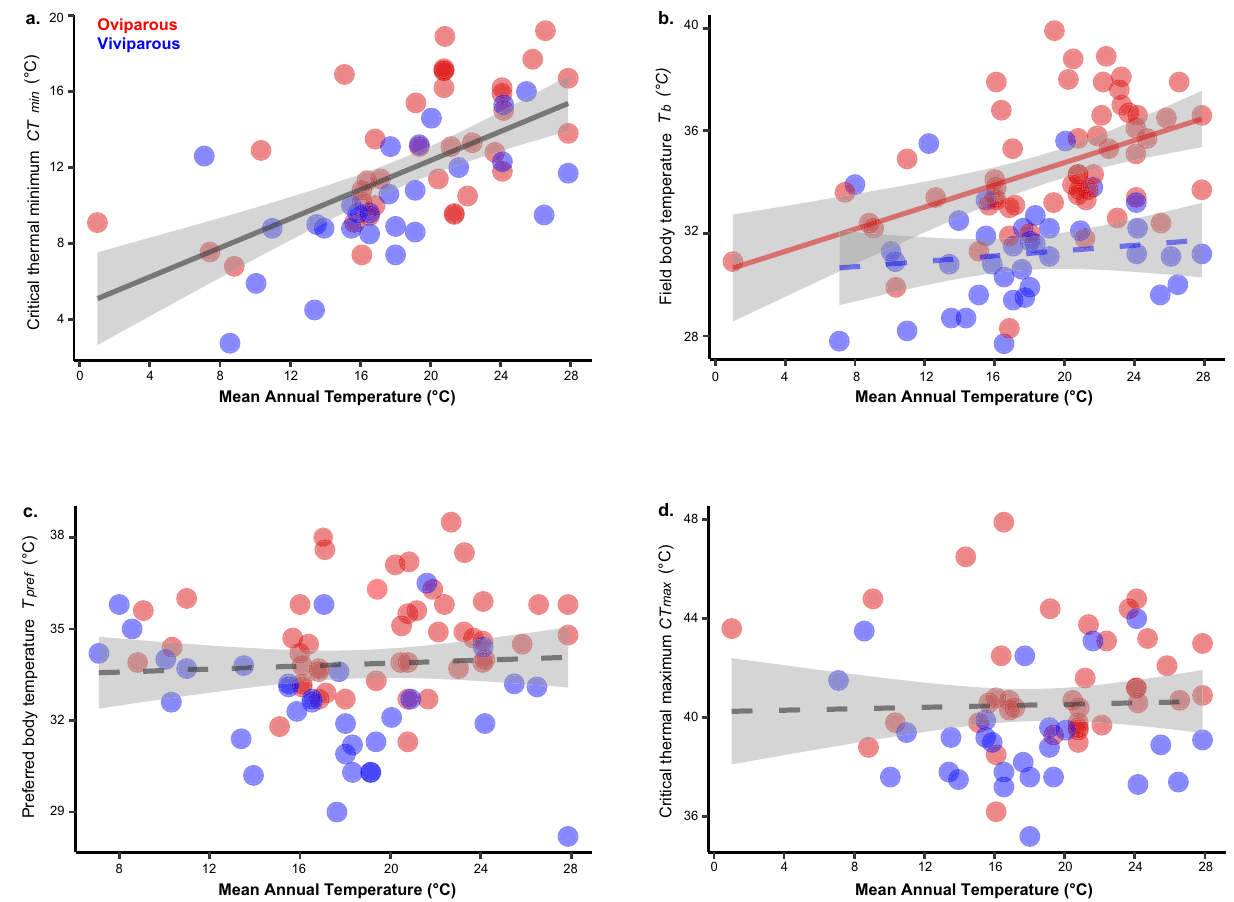
Fig. 3 Phylogenetic regressions between the thermal environment, and the thermoregulatory behavior and thermal physiology in phrynosomatid lizards. In fl uence of mean annual temperature (MAT) on cold tolerance ( a ; y = 0.354 x + 5.639, two-sided P < 0.001, n = 36 oviparous species and 26 viviparous species), fi eld body temperature ( b ; for oviparous: y = 0.230 x + 30.3, two-sided P < 0.001, n = 55, and for viviparous: y = 0.055 x + 30.69, two- sided P = 0.4, n = 37), preferred body temperature ( c ; y = − 0.0202 x + 35.05, two-sided P = 0.6, n = 47 oviparous species and 32 viviparous species), and heat tolerance ( d ; y = 0.032 x + 41.29, two-sided P = 0.5, n = 37 oviparous species and 26 viviparous species). Solid lines represent slopes with statistical signi fi cance (<0.05), and dashed lines represent slopes that are not statistically different from 0. Data are presented as mean values, and 95% con fi dence bands are included around regression lines. The regression slopes were estimated by phylogenetic regressions (PGLS), and the PGLS results using the other macroclimatic predictors (bio10 and bio11) and operative temperatures ( T e ) are given in Supplementary Table 4. Parity mode did not impact the relationship between MAT and CT min ( a ), T pref ( c ), or CT max ( d ); therefore, data were combined for oviparous and viviparous species (as indicated by a single gray regression line). By contrast, parity mode impacts the relationship between MAT and T b ( b ), as the P -value (0.02) was below the